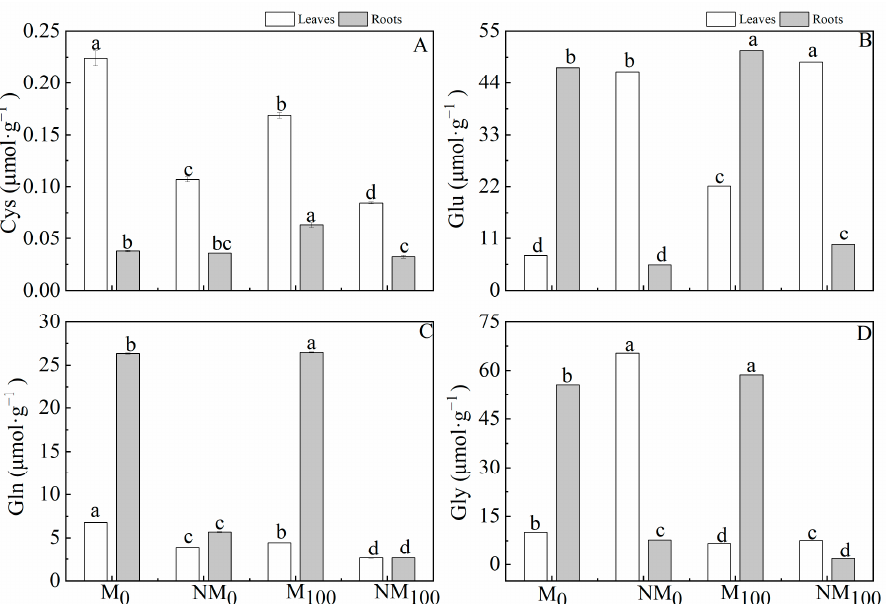
Figure 5. Contents of cysteine (Cys, ( A )), glutamic acid (Glu, ( B )), glutamine (Gln, ( C )), and glycine (Gly, ( D )) in leaves and roots of Neva irrigated with or without magnetized water following exposure to 0 or 100 µ mol · L − 1 cadmium stress. Values are the means ± SE of at least three replicates. Different lowercase letters indicate significant differences among the four treatments at the 0.05 level in leaves and roots.